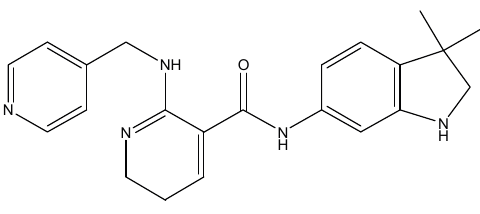
Figure 16. Structure of